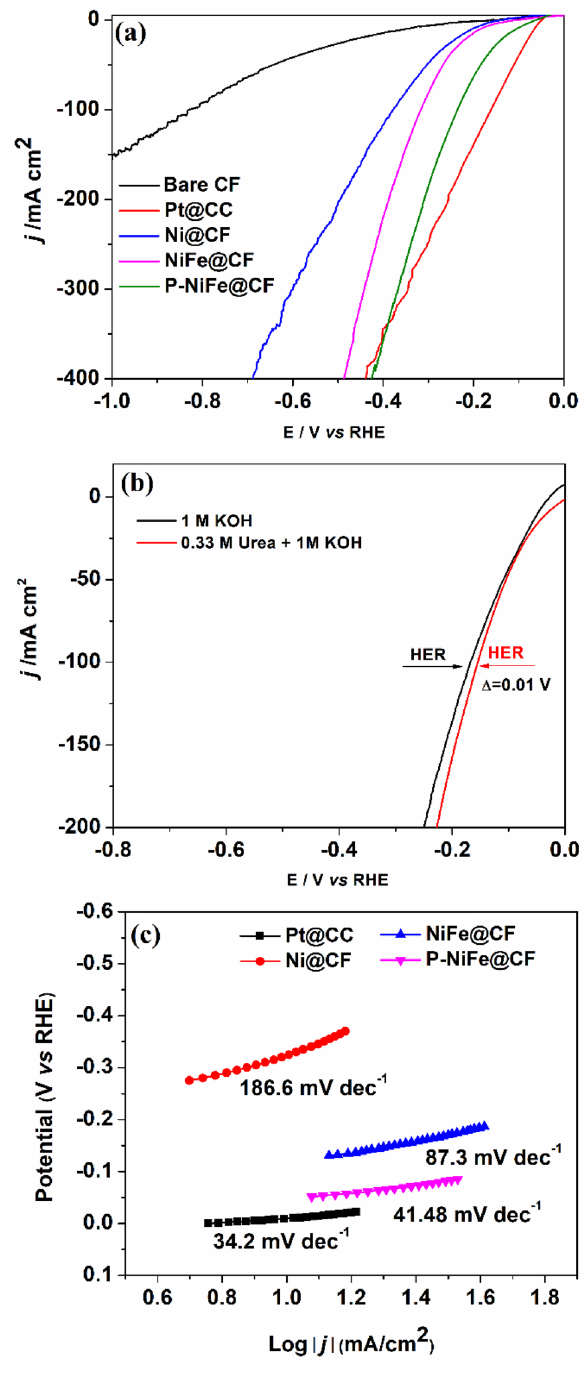
Figure 4. ( a ) LSV curves of different catalyst electrodes in 1.0 M KOH at a scan rate of 5 mV s −1 , ( b ) LSV curves of P-NiFe@CF in 1.0 M KOH with and without 0.33 M urea, and ( c ) Tafel plots of different catalysts in 1.0 M